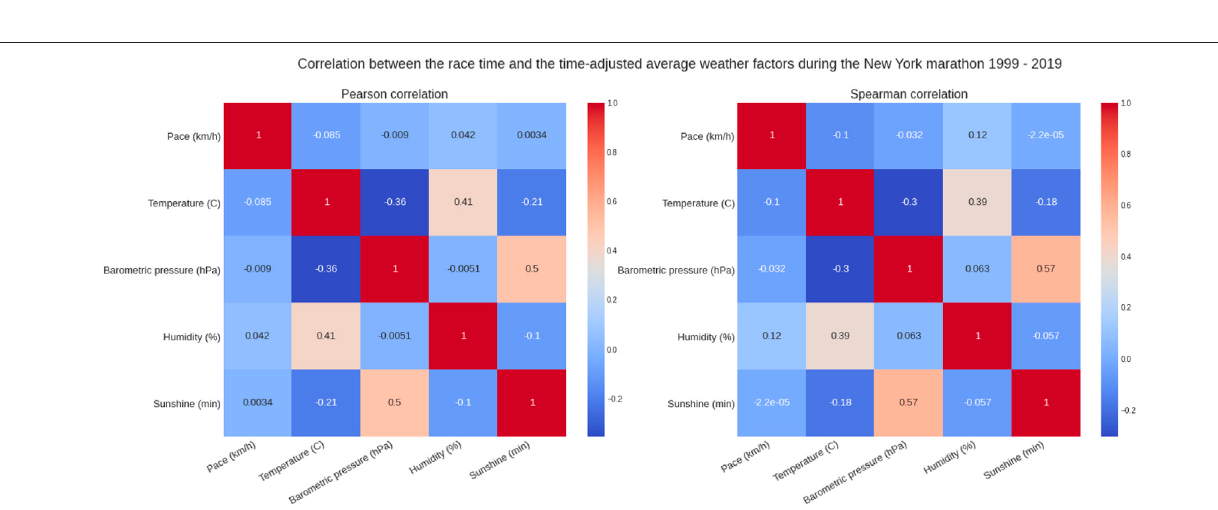
Frontiers in Physiology |